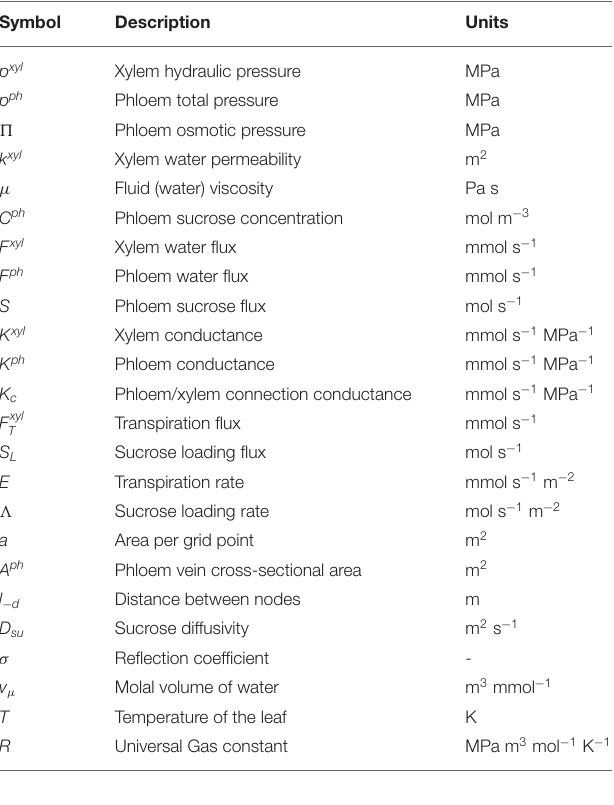
TABLE 2 | Summary of parameters and function variables (at node ij , subscripts not shown).